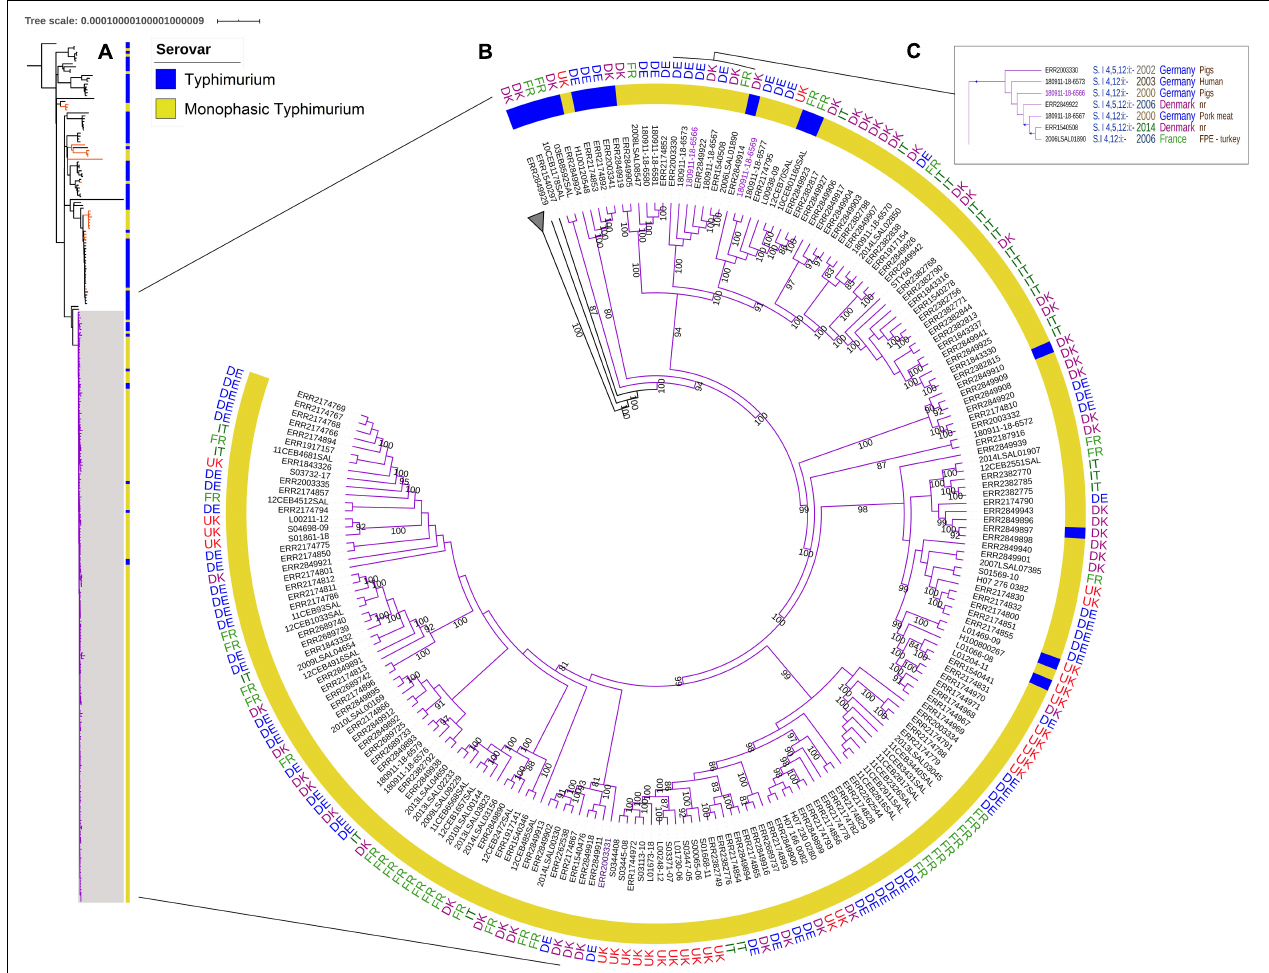
FIGURE 1 | (A) SNP core genome phylogenetic tree of 298 S. Typhimurium and S . 1,4,[5],12:i:- strains. The main clade A including 90% of the S. 1,4,[5],12:i:- is in purple. Orange branches indicate the other S. 1,4,[5],12:i:- genomes within clade B. (B) SNP core genome phylogenetic tree of the clade A. The branch length